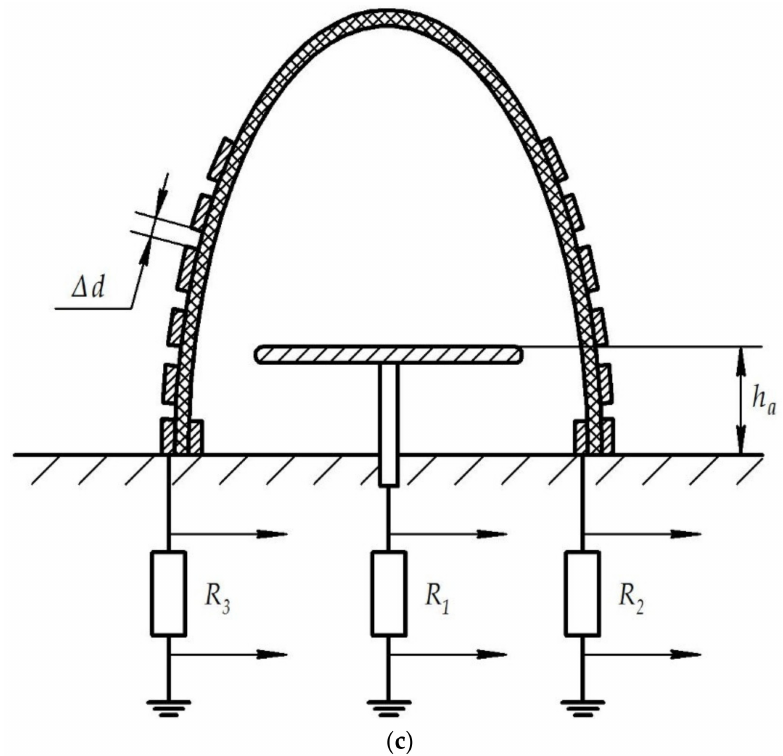
Figure 3. Various setups of lightning protection for aircraft radome (( a ) radomes without installed lightning protection; ( b ) radomes with vertical lightning diverter strips; ( c ) radomes with vertical segmented lightning diverter strips on outer